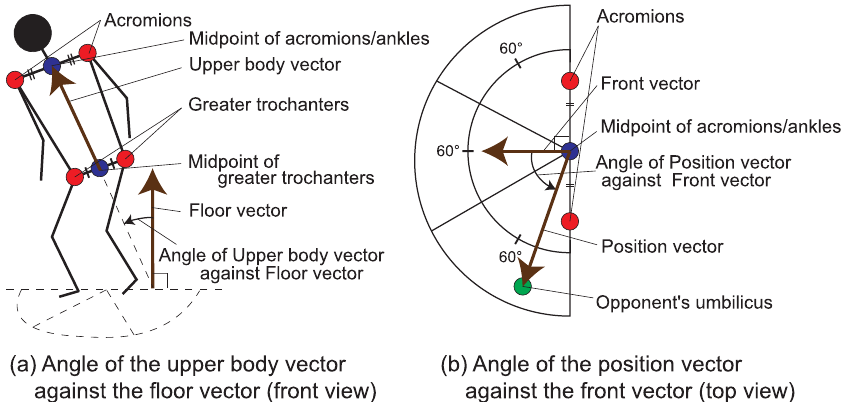
Figure 3. The angles and the vectors to determine the candidate factors. ( a ) The angle of the upper body vector against Floor vector from the front view. ( b ) The angle of the position vector against the front vector from the top view.